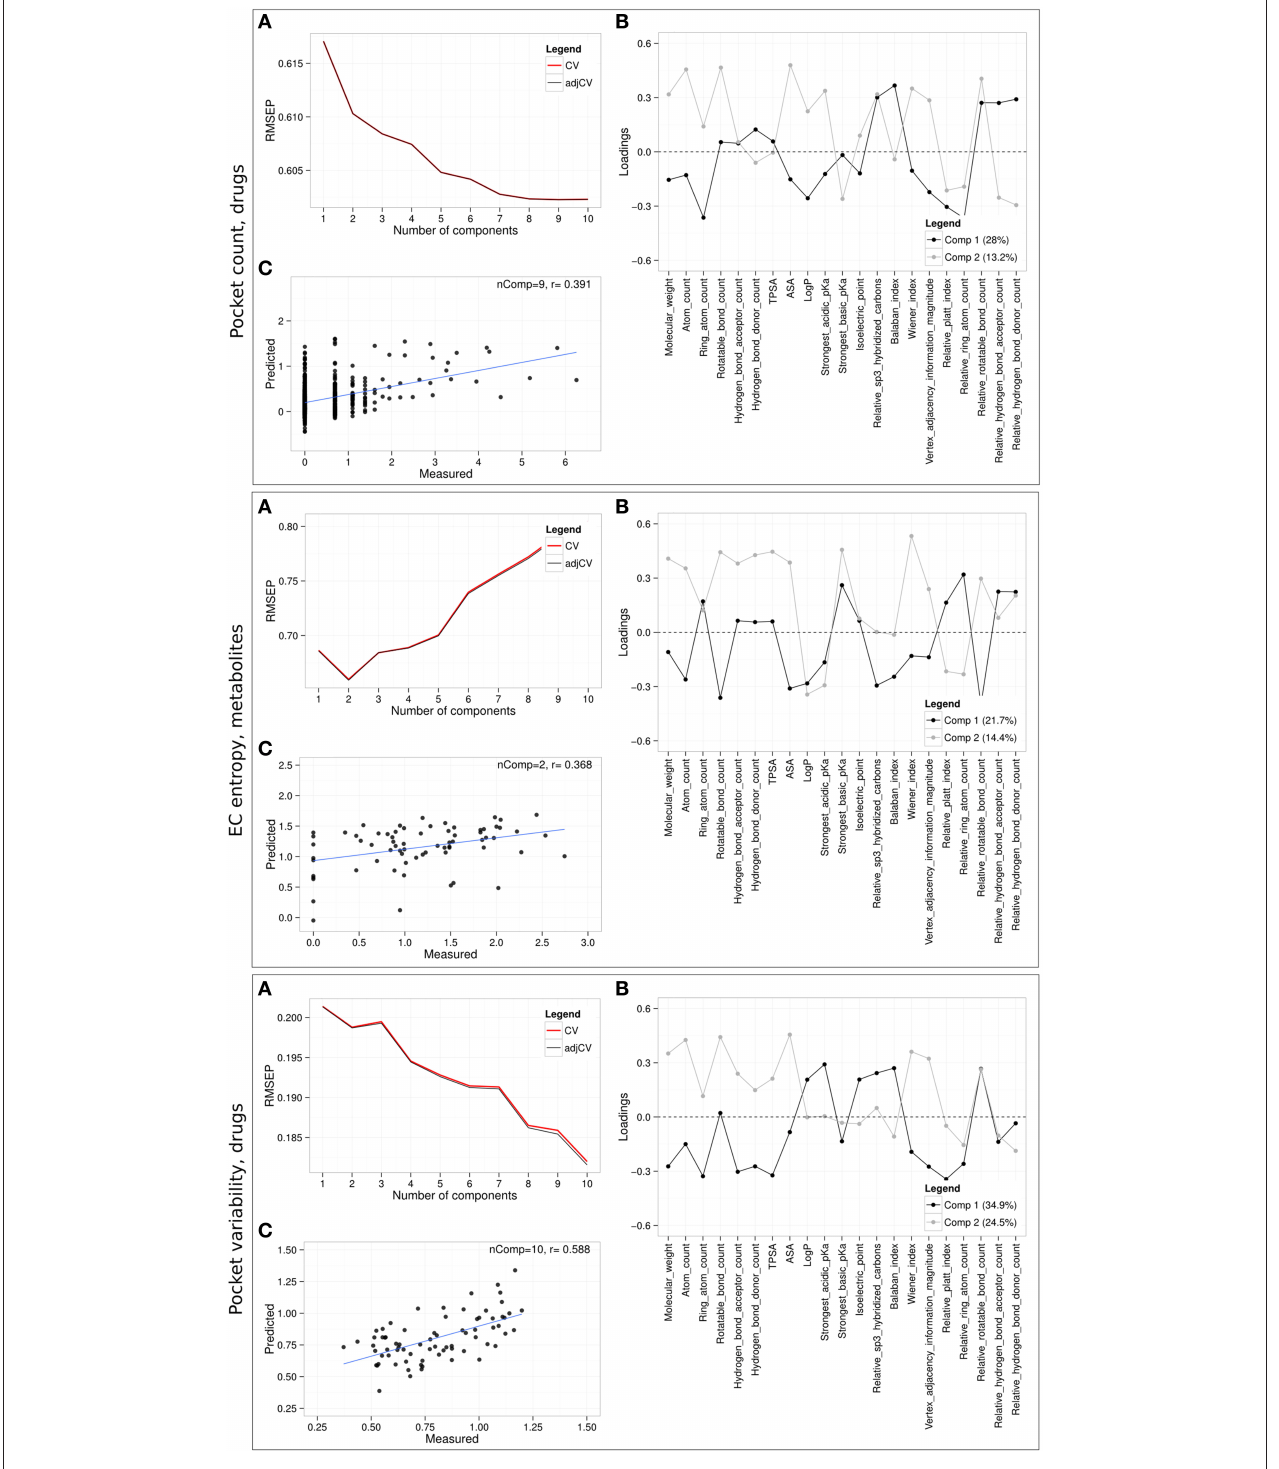
FIGURE 8 | Partial least squares regression (PLSR) using physicochemical properties. PLSR prediction models were built for drug promiscuity (logarithmic pocket count), drug pocket variability and EC entropy of metabolites. (A) Cross-validated (CV) RMSEP (root mean square error of prediction and adjusted CV) curves as function of the number of components in the model, (B) loading plot of the physicochemical properties for the first two components, and (C) measured against predicted values including the number of components used in the final prediction model (nComp) and correlation coefficient, r, in a leave-one-out cross-validation setting. PLS models for the respective additional compound classes resulting in inferior performance relative to the one shown here are presented in Supplementary Figures 3, 4.